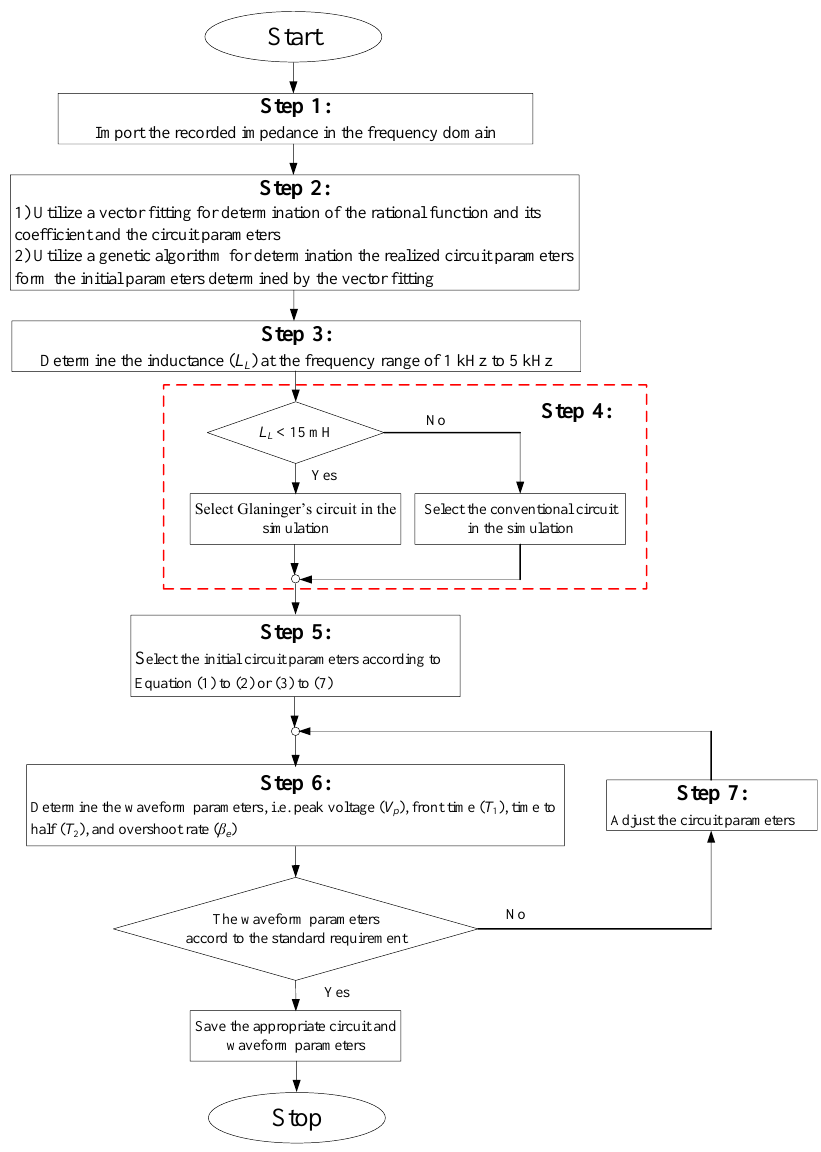
Figure 8. Flowchart of the proposed approach for determination of the generator circuit parameters.